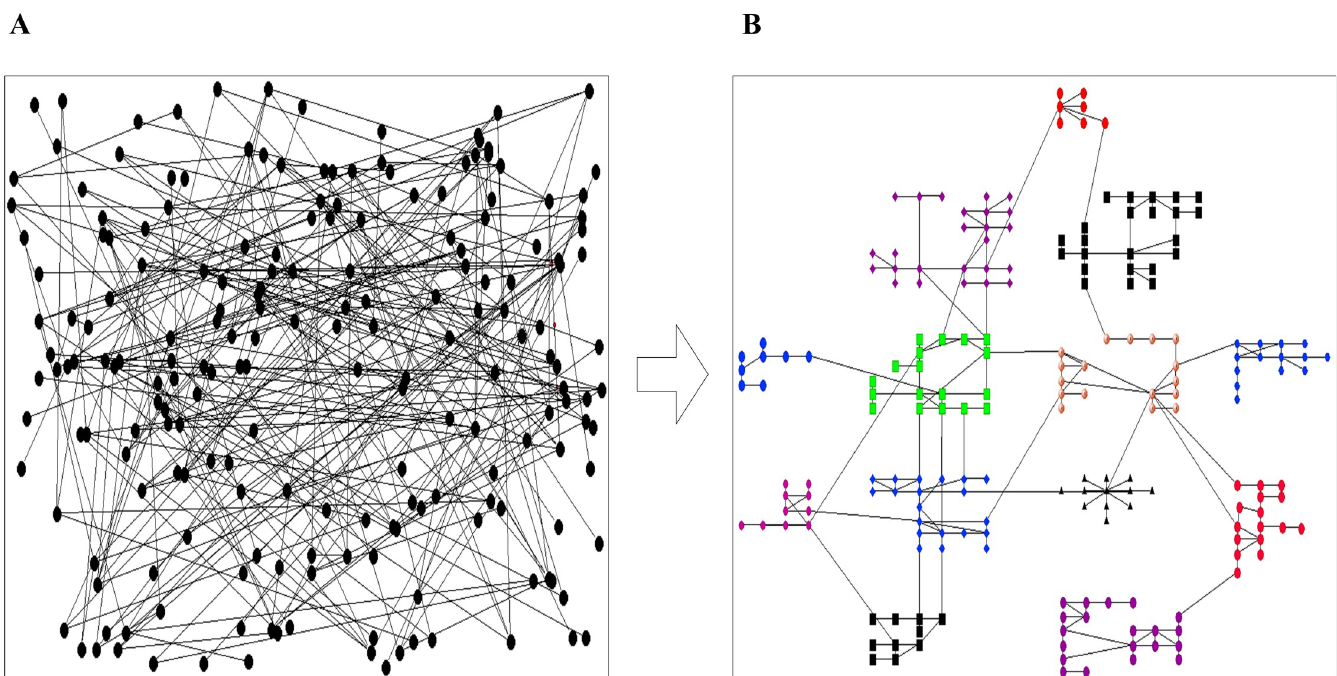
Fig 3. A layout of the yeast cell cycle regulatory network of 200 nodes visualized by the GML algorithm. A) random layout: the nodes were positioned randomly; B) GML layout: the nodes were optimized with the GML algorithm.